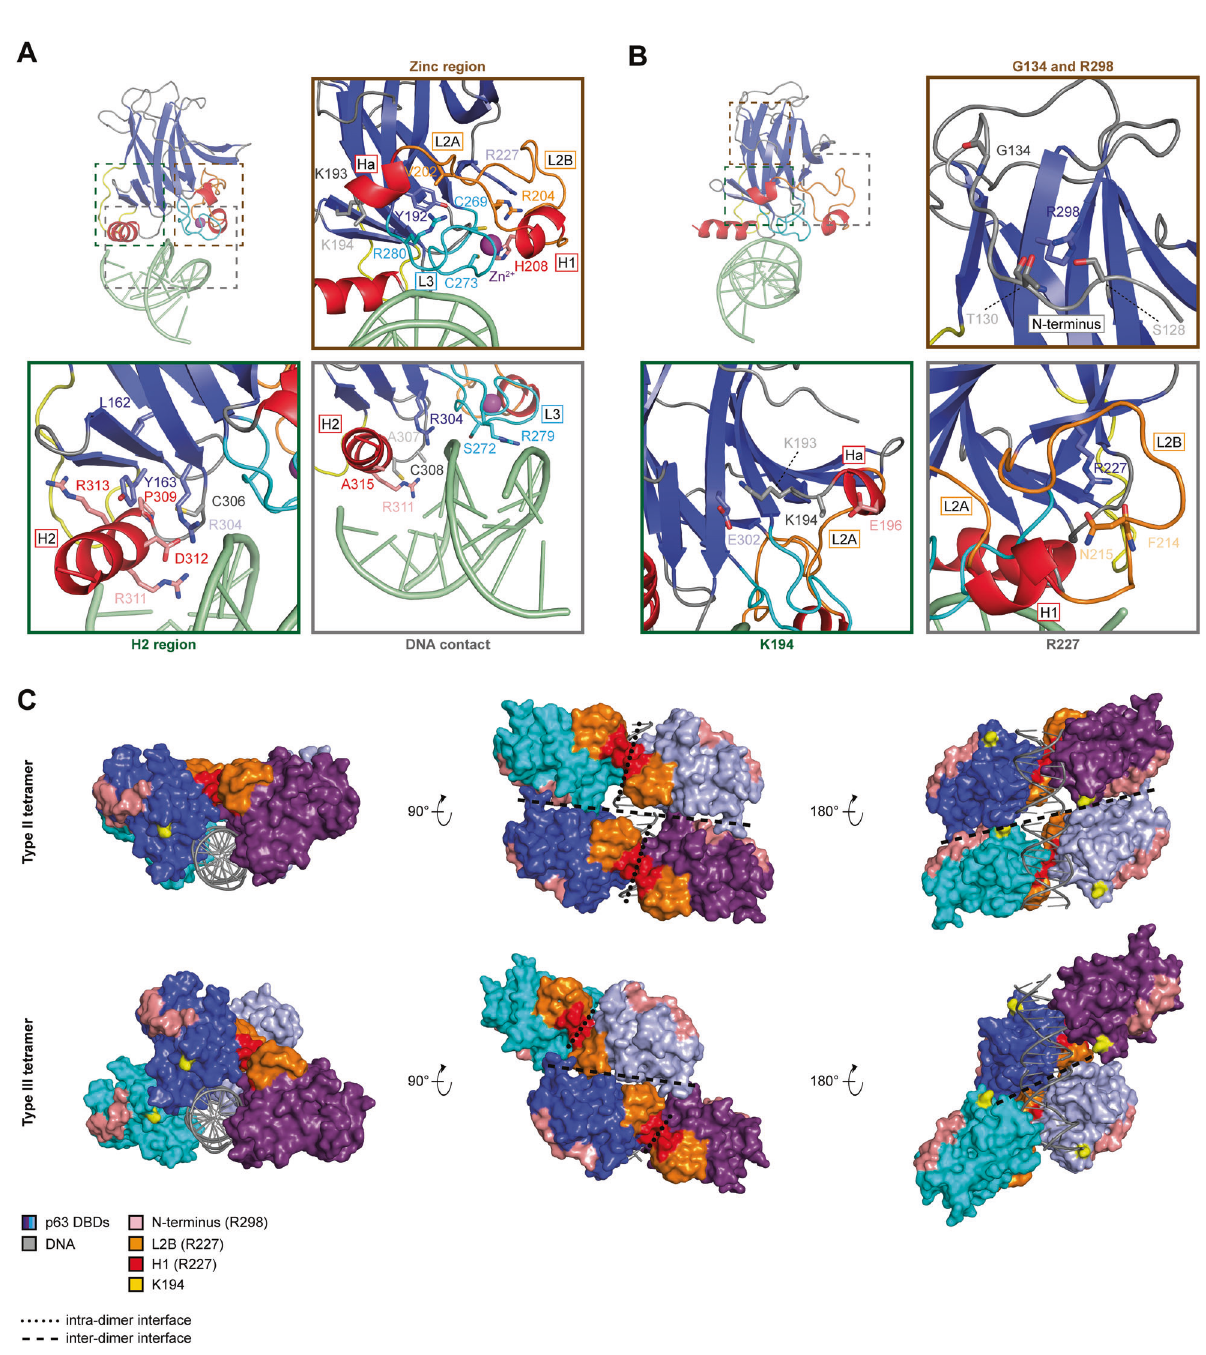
Fig. 6 p63 R227Q and R298Q bind to incomplete consensus sequences. A Schematic representation of the inducible system for conversion of human dermal fi broblasts (HDFs) to keratinocyte-like cells (iKCs). HDFs with a stable integration of a reverse tetracycline-controlled transactivator (rtTA) are retrovirally transduced with KLF4 only or C-terminally fused to Δ Np63 α with a self-cleaving T2A peptide. Conversion is achieved by doxycycline (Doxy)-induced expression of p63 and KLF4 for 72 h. Cells were subsequently analysed by ATAC- and RNA-seq. B Venn diagram of ATAC-seq peaks in HDF expressing either WTp63/KLF4 (light brown) or KLF4 alone (CTR; in light blue) showing the number of open regions (-Log10FDR ≥ 10). C Percentage of ATAC-seq peak distribution in promoters, intergenic, or intragenic regulatory elements of the sequences open in both CTR HDF and p63 expressing HDF (cluster 1), in those open only in CTR HDF (cluster 2), or in p63 expressing HDF (cluster 3). D Upper panel: Heat map representation of the signal density of p63 WT and the indicated DBD mutants sequence tags with a stringency of -Log10FDR ≥ 20. p63 binding sites were distributed within ±5 kb from the WT peak summit. Lower panel: Mean read densities centred (±5 kb) around the peak summits. E Percentage of peak distribution bound by p63 WT or the indicated DBD mutants in promoters, intergenic, or intragenic regulatory elements. F De novo discovery motifs using STREME performed on 100 bp spanning the summits of the top 1000 ChIP-seq peaks (-Log10FDR ≥ 20) of p63 WT and DBD mutants. E-value, and the distribution are shown. G p53 p63 consensus motif scanning (MA0106.30525.1 (TP53)) identi fi ed by CentriMo using MEME-ChIP. E-value, and the distribution are